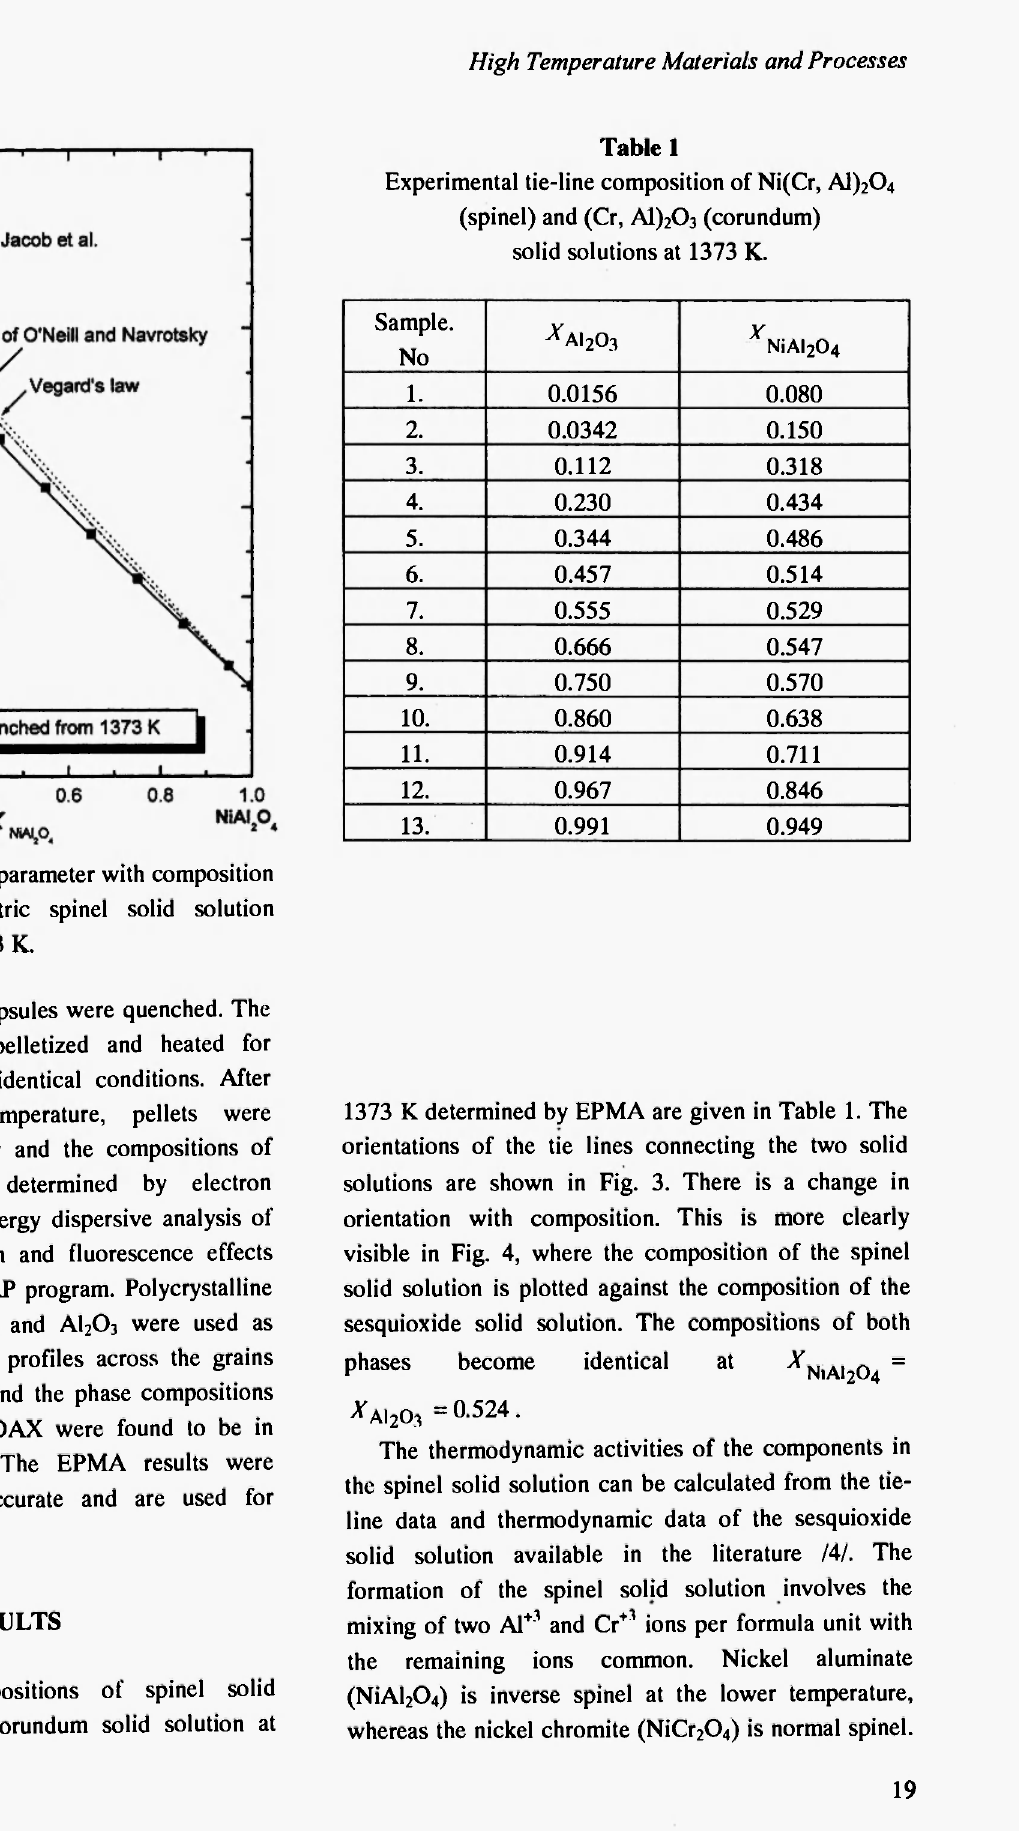
Experimental tie-line composition of Ni(Cr, A1) 2 0 4 (spinel) and (Cr, Α1) 2 0 3 (corundum) solid solutions at 1373